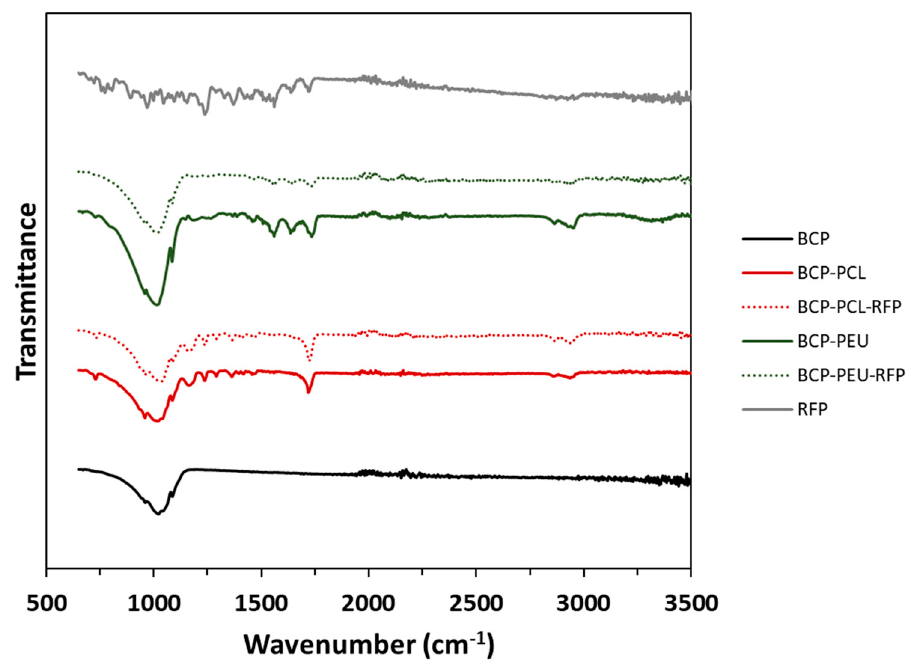
Figure 2. FTIR-ATR of BCP scaffolds, uncoated and after coating with different polymers (BCP-PCL and BCP-PEU) and further loaded with RFP (BCP-PCL-RFP and